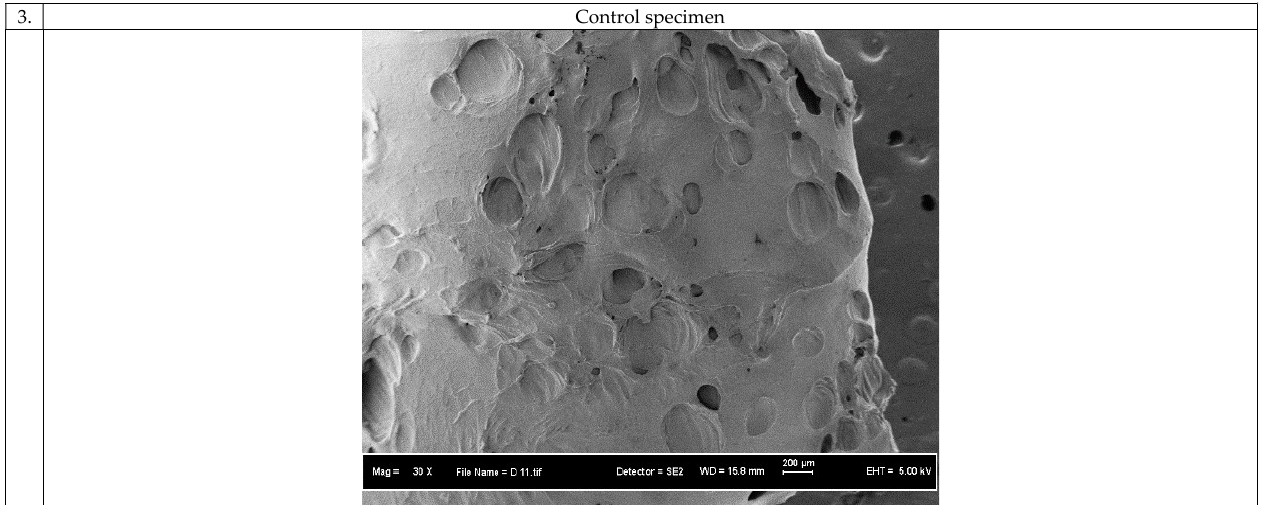
Figure 11. Cell morphology on the cross section of the 3D scaffolds after 7 days’ cell seeding.